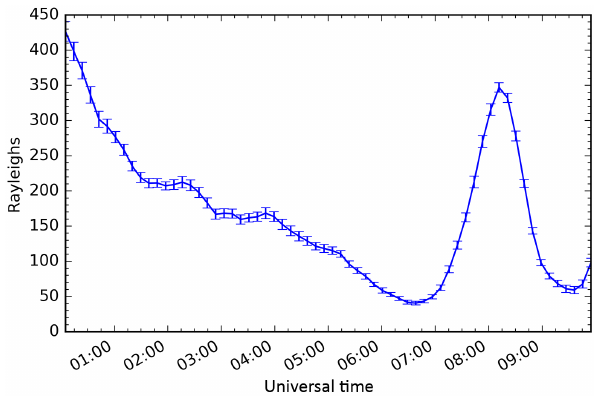
Figure 12. An MTM observed on 4 April 2014. Blue dots show the ion temperatures as measured by the ISR. Green points are the neutral temperatures measured by the FPI. The peak of the MTM occurs between 06:00 and 06:30UT (01:00 and 01:30LT).